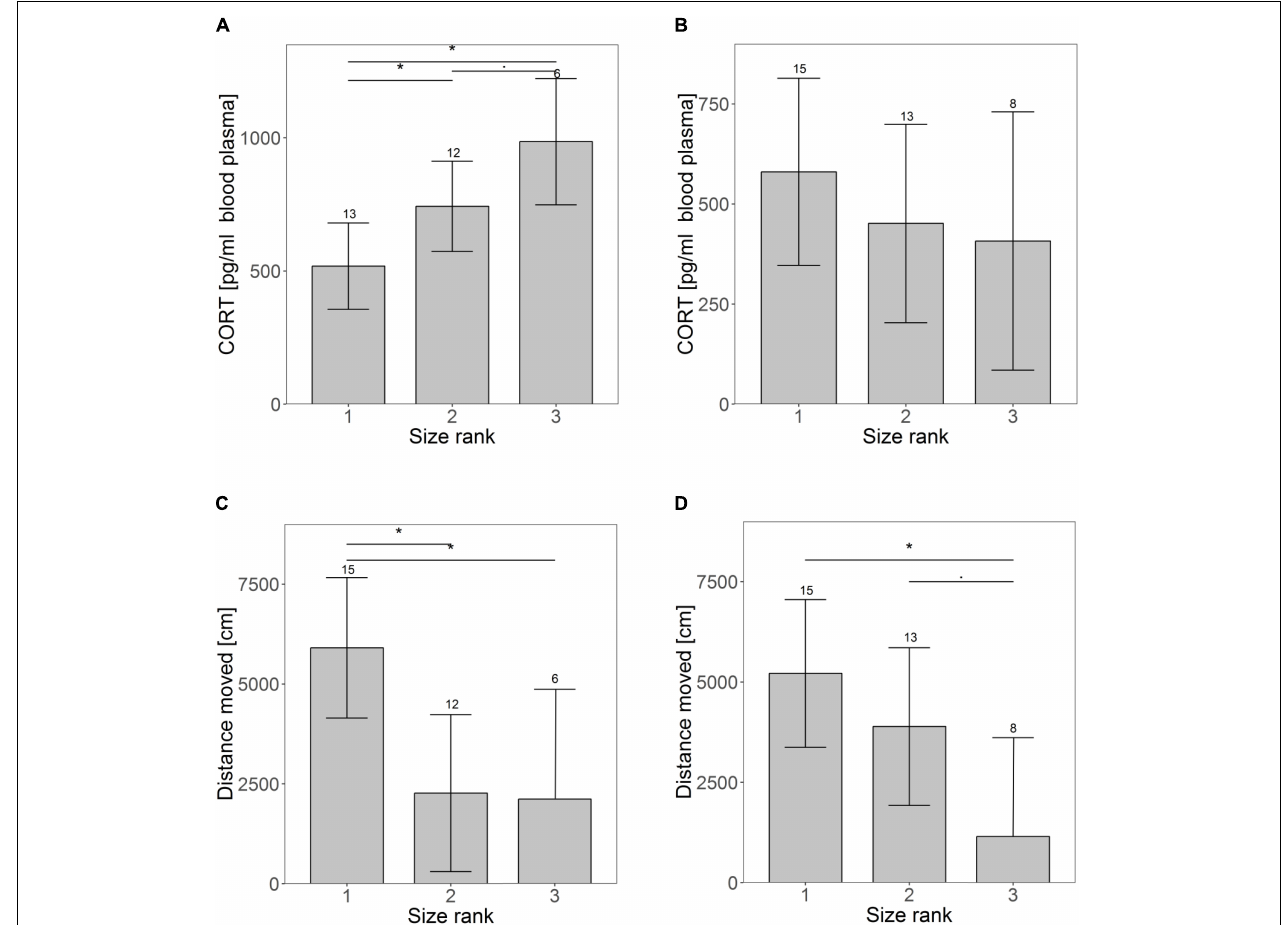
FIGURE 1 | Differences in personality and physiological traits over time for pups of different size ranks (1 indicates the largest pup). Panel A and B show differences in basal cortisol levels at the time of weaning (A) and maturation (B ). The images shows the distance moved in an open field at weaning (C) and maturation (D) . Shown are the estimated values derived from the mixed models on the behavioral traits ± confidence intervals (CI). Asterisks indicate significant differences among size ranks. Samples sizes are given above the